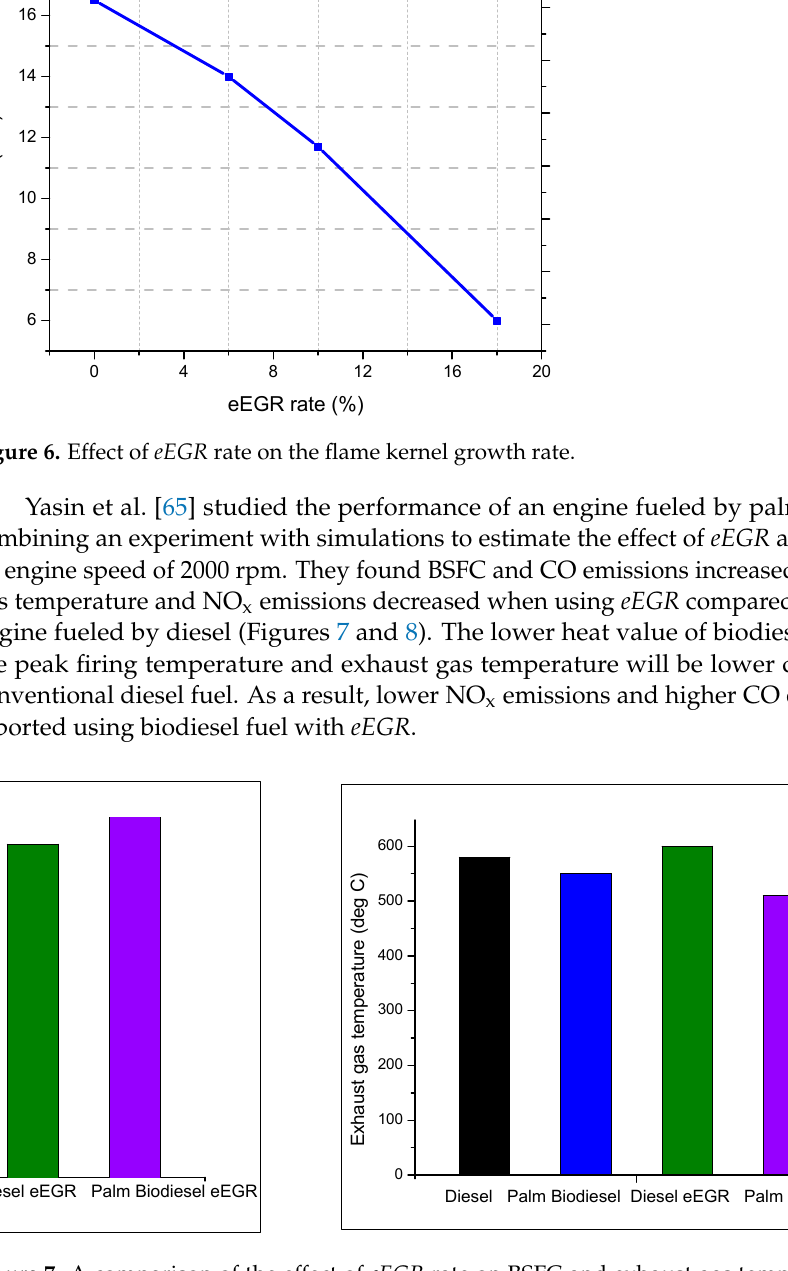
Figure 7. A comparison of the effect of eEGR rate on BSFC and exhaust gas temperature between diesel and palm oil biodiesel.